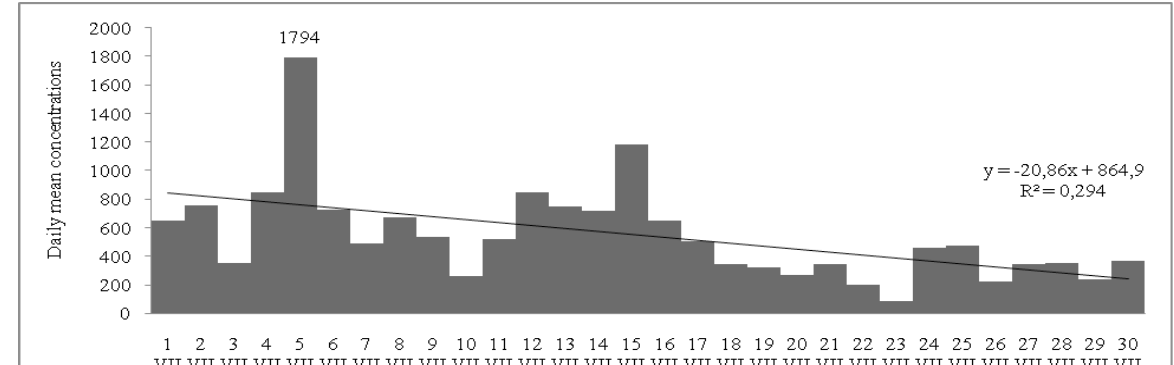
Fig. 1. Totals of spores in the air recorded in Timisoara in July